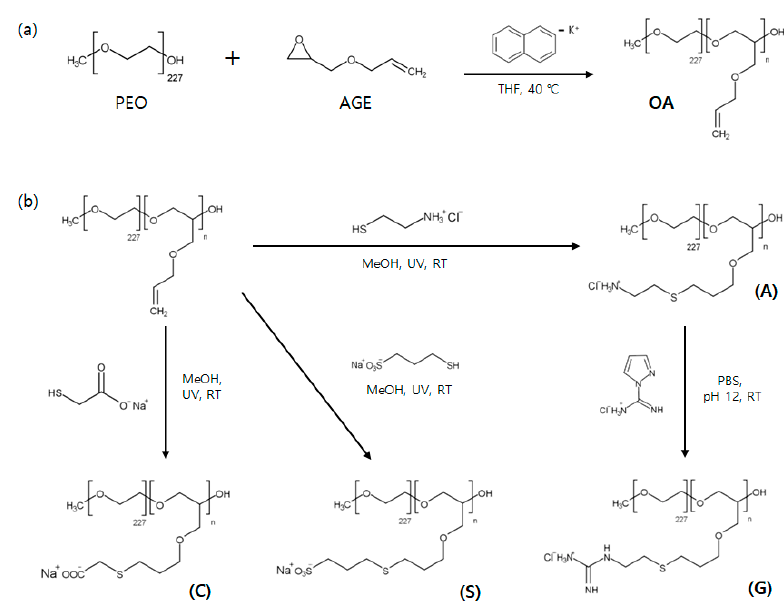
Figure 1. Synthetic scheme of ( a ) OA diblock copolymers using anionic ring-opening polymerization, and ( b ) post-modification of allyl group by thiol-ene “click” chemistry to introduce functional group of ammonium (A), guanidinium (G), carboxylate (C), and sulfonate (S).